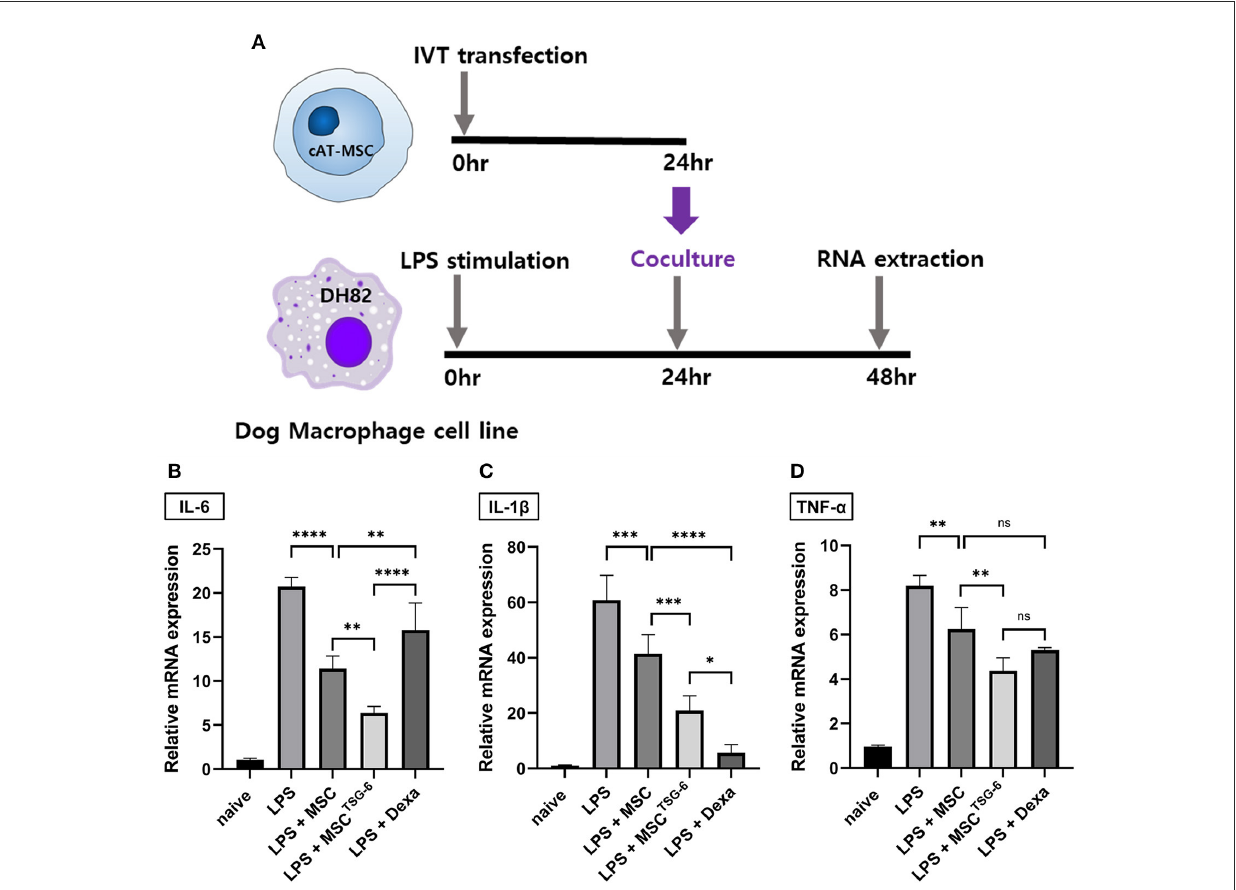
FIGURE5 MSC TSG-6 co-culture altered the phenotype of DH82 macrophages. (A) Schematic diagram of co-culture with DH82 cells and MSCs TSG-6 . (B–D) LPS treatment-induced M1 polarization of DH82 cells. IL-6, IL-1 β , and TNF- α were used as M1 phase markers. The mRNA expression of these markers increased significantly in LPS-stimulated DH82 cells. Co-culture of these cells with naïve MSCs or MSCs TSG-6 reduced the mRNA level of M1 markers. MSCs TSG-6 more effectively reduced the expression of M1 markers than naïve MSCs did. (B) MSCs TSG-6 more effectively reduced IL-6 expression than dexamethasone did. (C) mRNA level of IL-1 β showed a greater decrease with dexamethasone than MSCs TSG-6 . (D) MSCs TSG-6 and dexamethasone reduced TNF- α mRNA expression to a comparable degree. Results are shown as the mean ± standard deviation obtained in three